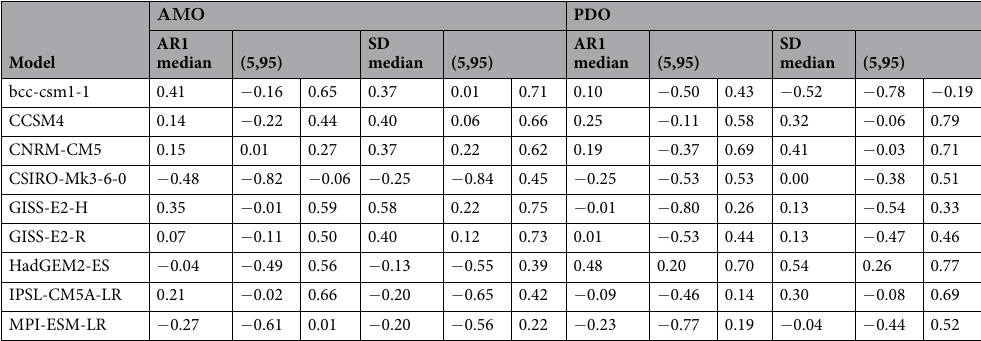
Table 2. Autocorrelation and variance trends in model simulations of the AMO and PDO climate indices (1957–2002). Trends expressed as Kendall τ values. Medians as well as 5 and 95 percentiles from the estimated distributions (varying filtering bandwidth and sliding window length) are